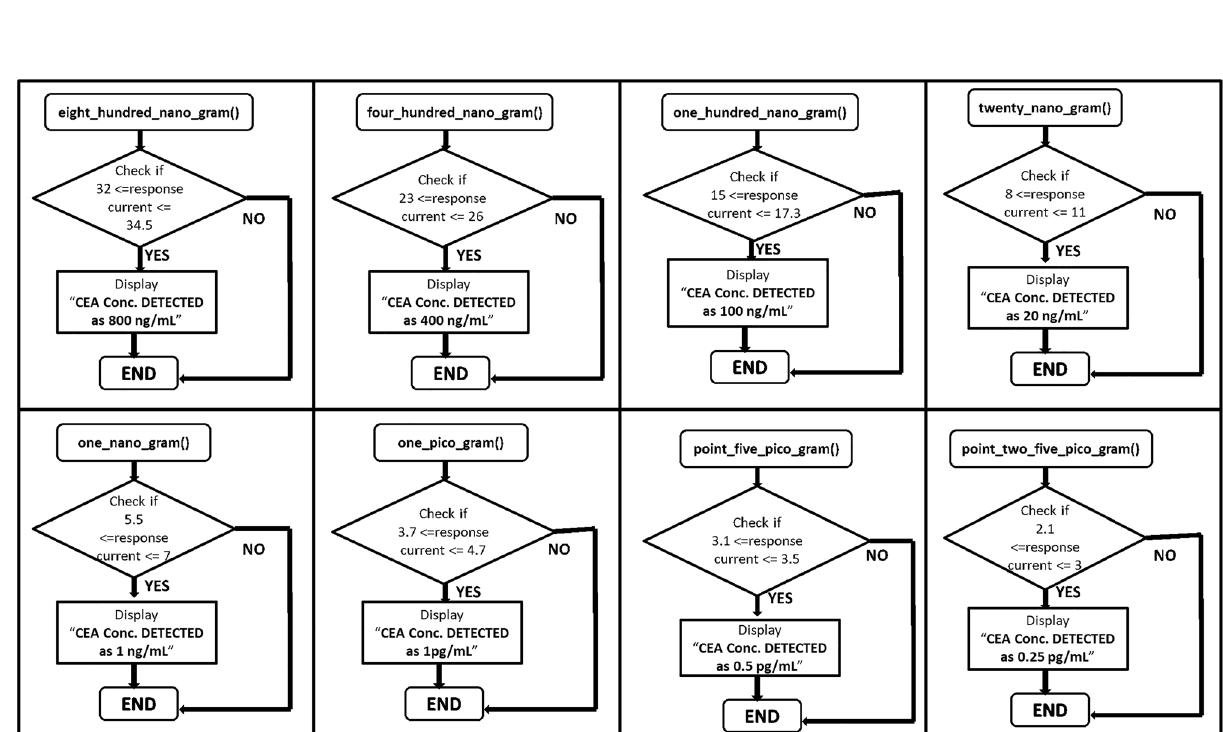
Figure 9. Flowchart of the subroutines used for the prediction of CEA